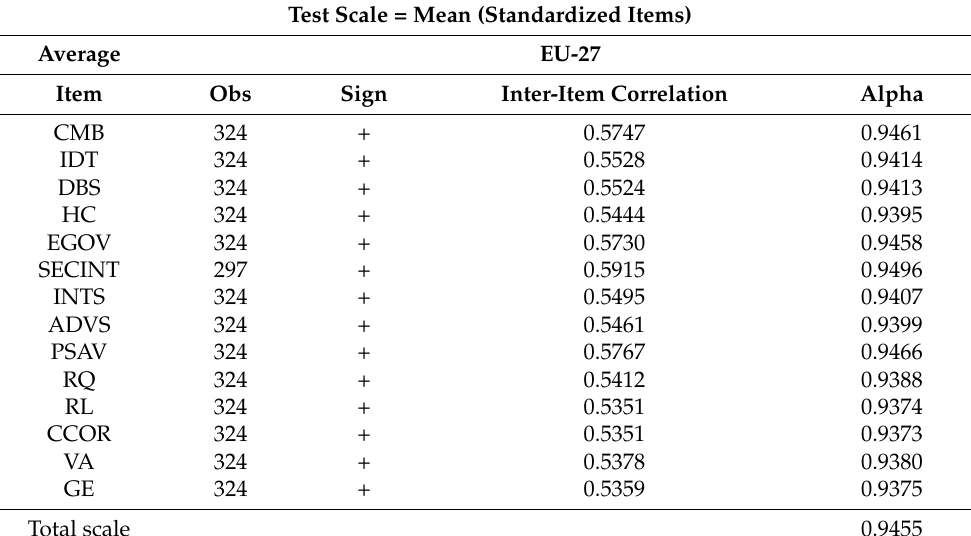
Table A2. Cronbach’s alpha for the SEM model, EU-27,